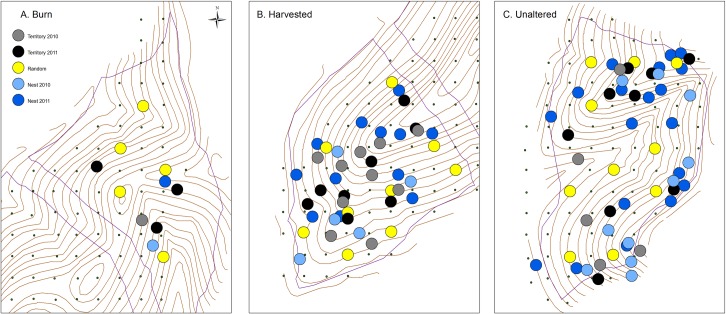
Map illustrating the location of the habitat plots used to estimate vegetation composition and structure.We show the positions for the different plot types (male territory centered, nest centered, and random) each year in (A) burn habitat, (B) harvested habitat and (C) unaltered habitat.